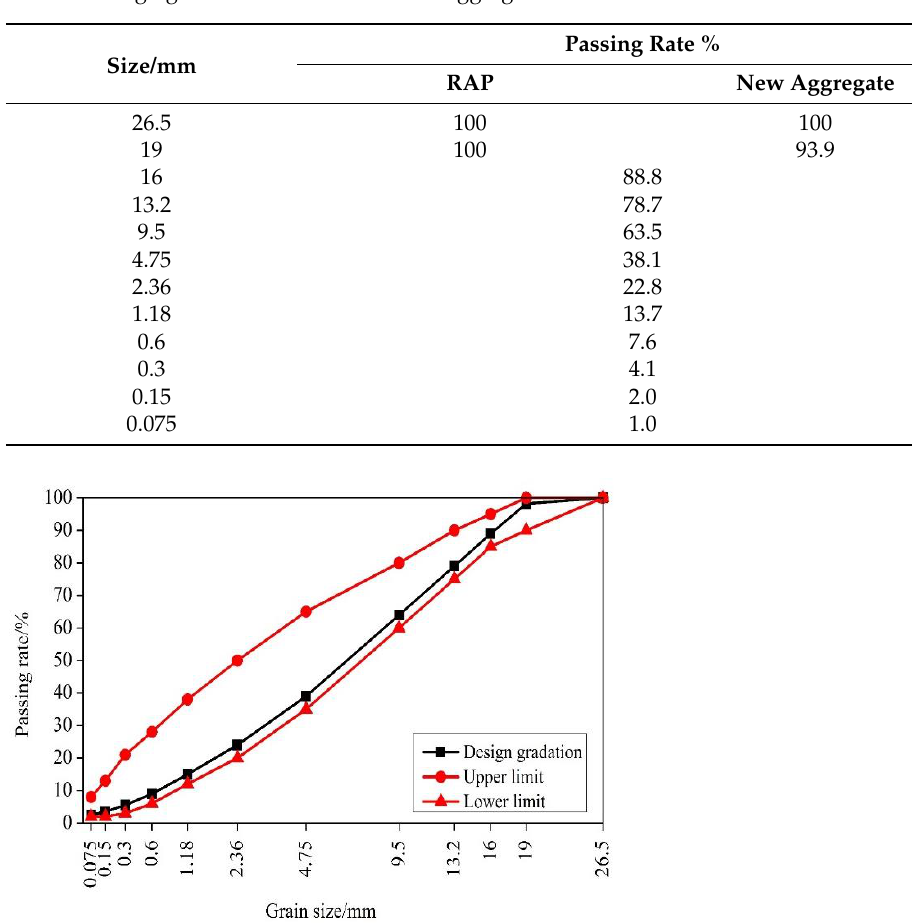
Table 4. Design gradations of RAP and new aggregate.